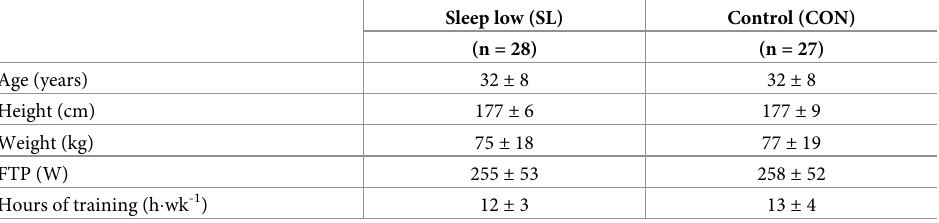
Table 1. Participants’ characteristics in the sleep low and control groups, 12:3 male to female ratio in each group. (mean ± SD). Sleep low (SL) Control (CON)